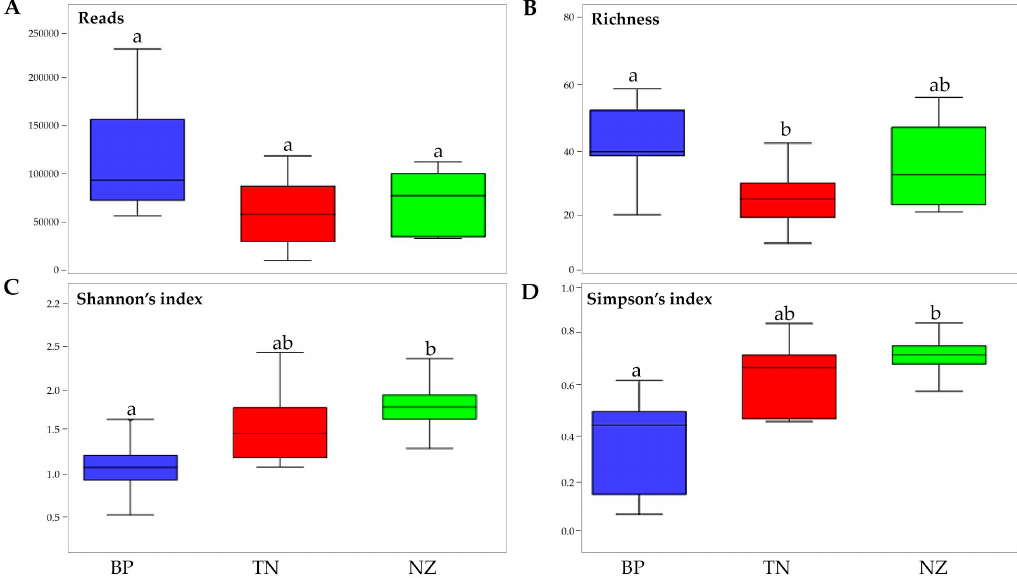
Figure 5. Fungal biodiversity indices. ( A ) Number of reads, ( B ) richness, ( C ) Shannon’s index, ( D ) Simpson’s index. Boxplots show 25th and 75th percentile, while error bars show 1st and 99th percentile. Same letters indicate that no significant differences occurred among the site, according to the one-way ANOVA Tukey HSD test ( p < 0.05).